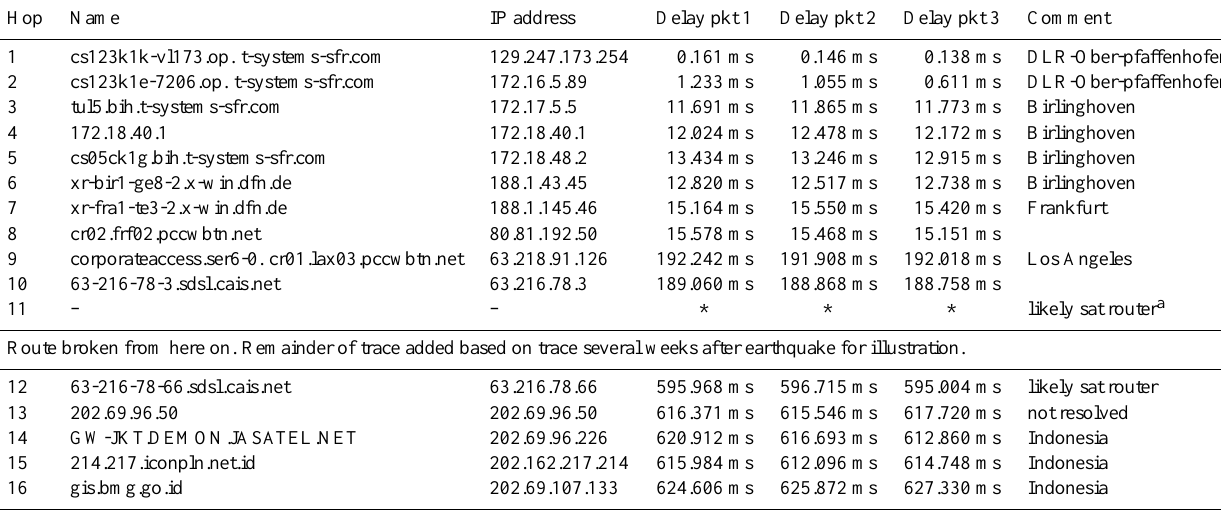
Table 2. Traced route originating from host in Oberpfaffenhofen, Germany within DFN (Deutsches Forschungsnetz) towards host at BMKG’s Jakarta premises in Indonesia on 26 May, approx. 06:30UTC. The trace shows that the route is broken at the hop towards Indonesia, thus rendering Indonesia unreachable from within DFN. A router in Los Angeles is the last reachable hop in this trace. For illustration purposes the remainder of the route is added and marked red, based on a trace several weeks after the earthquake.